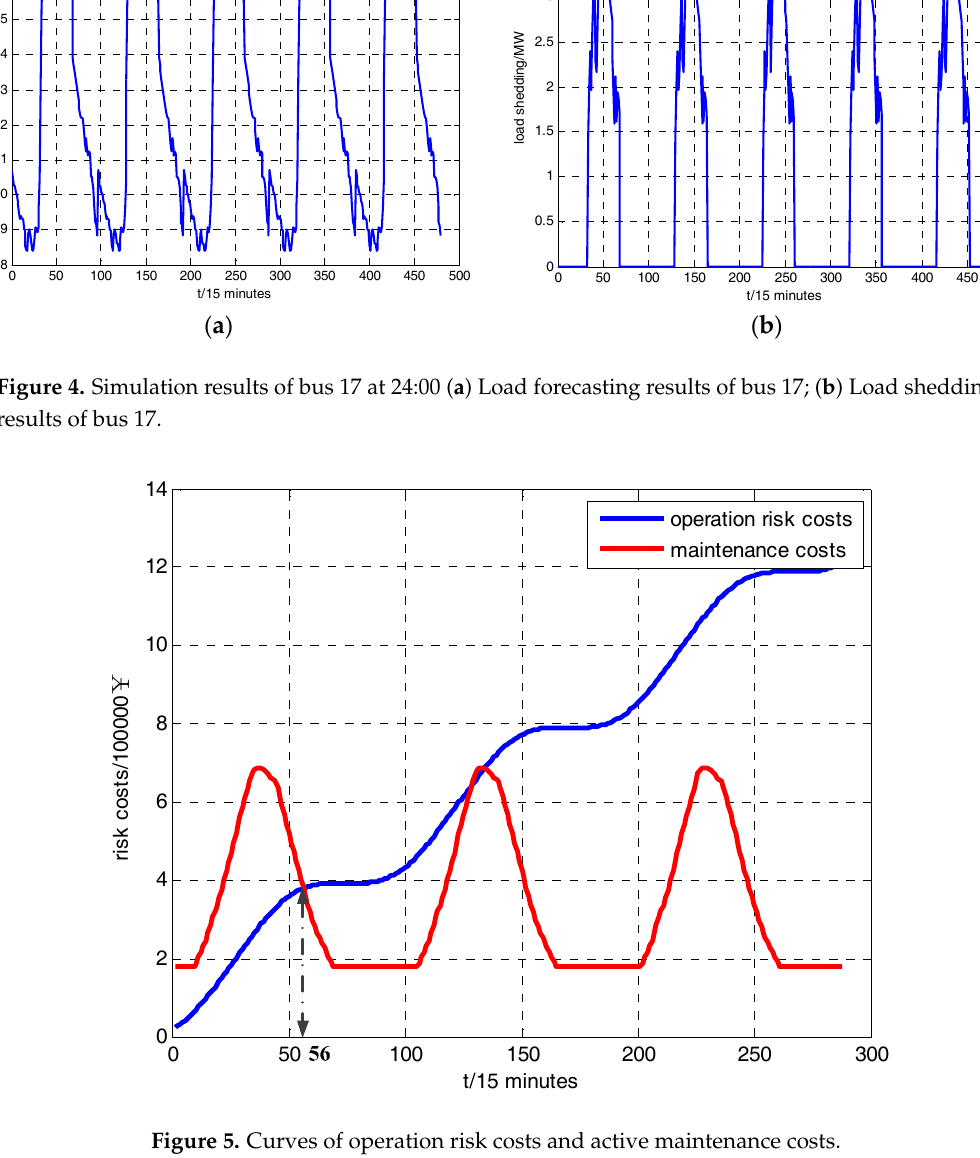
Figure 5. Curves of operation risk costs and active maintenance costs.